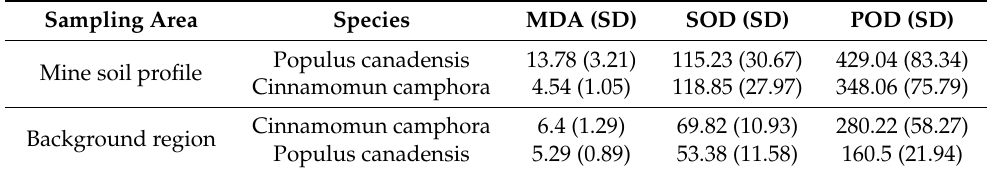
Table 5. The enzyme content of dominant plants.